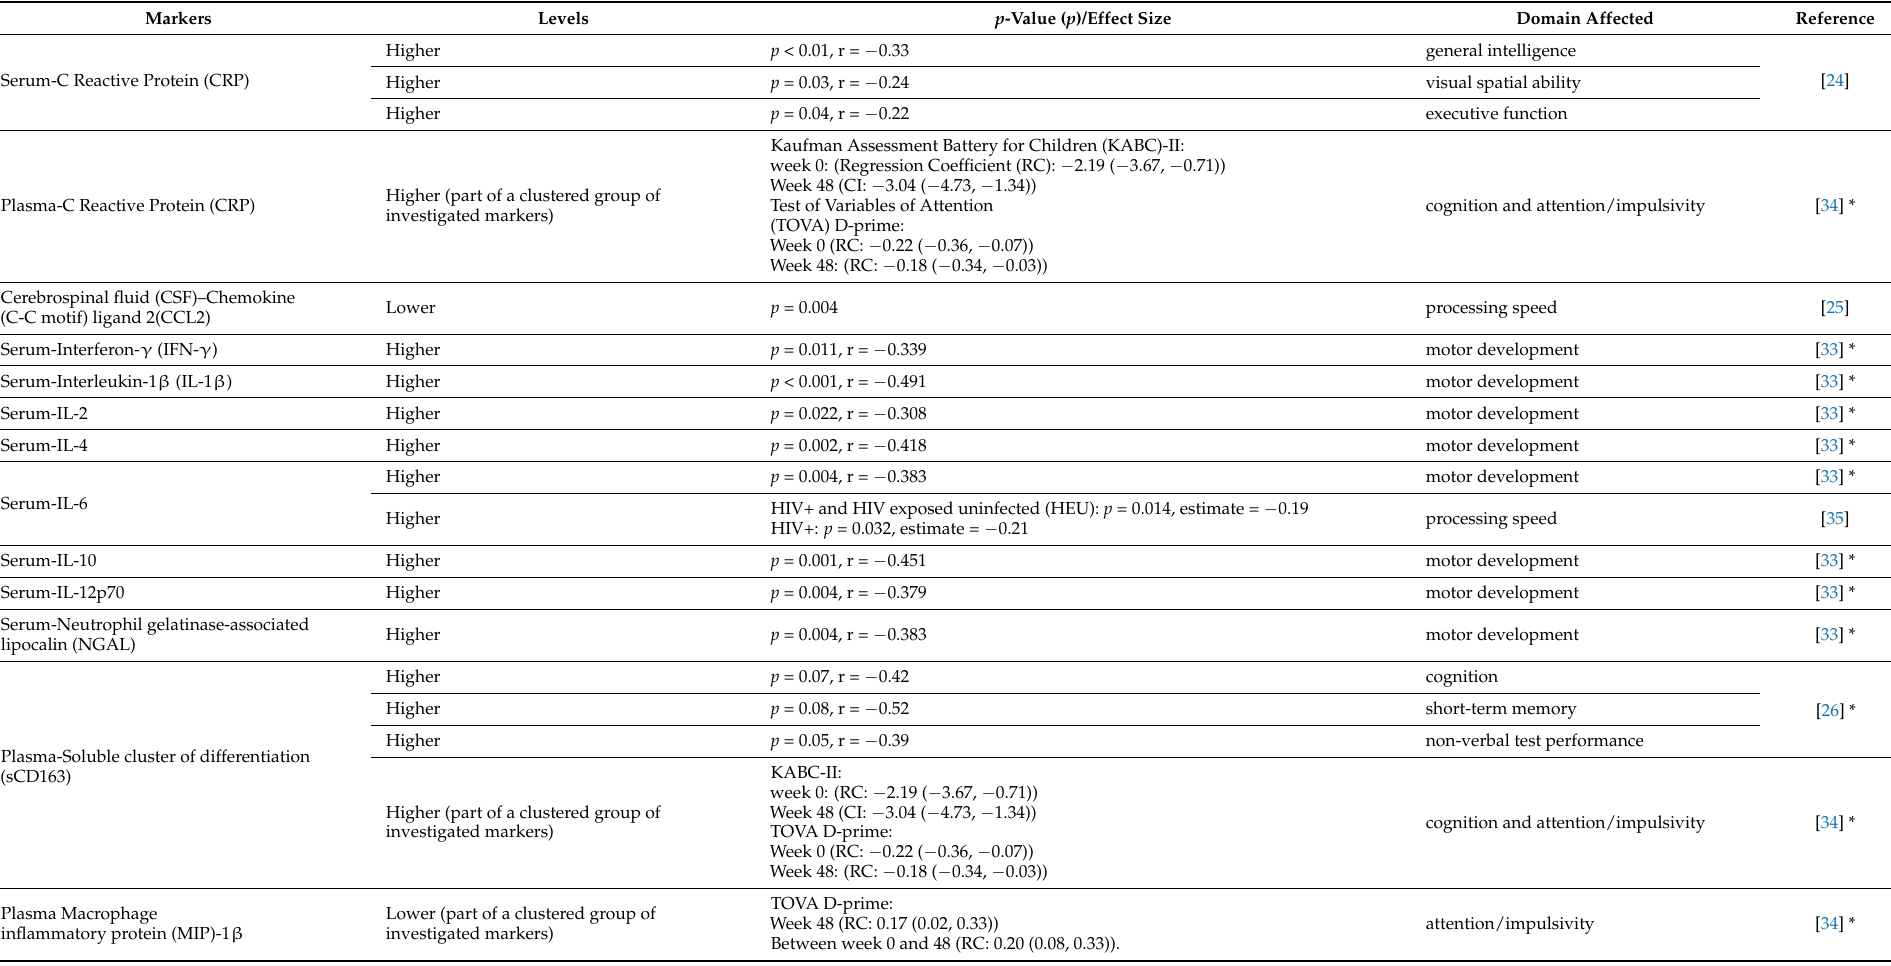
Table 1. Immune markers associated neurodevelopment delays and neurocognitive impairment in pediatric HIV